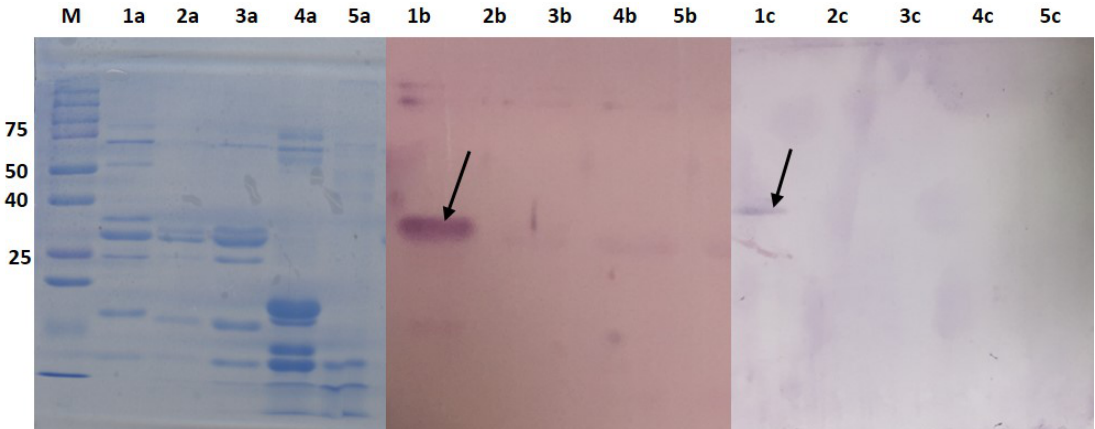
Figure 6. Western blot shows for total protein extract from 1: goat’s milk; 2: cow’s milk, 3: buffalo’s milk; 4: horse’s milk; 5: camel’s milk. a: SDS-PAGE; b: immunoblot for Nter IgG, c: immunoblot for Cter IgG. Each lane was loaded with 20 μg/mL of protein. Nter and Cter IgGs were loaded at 8 and 16 μg/mL, respectively.